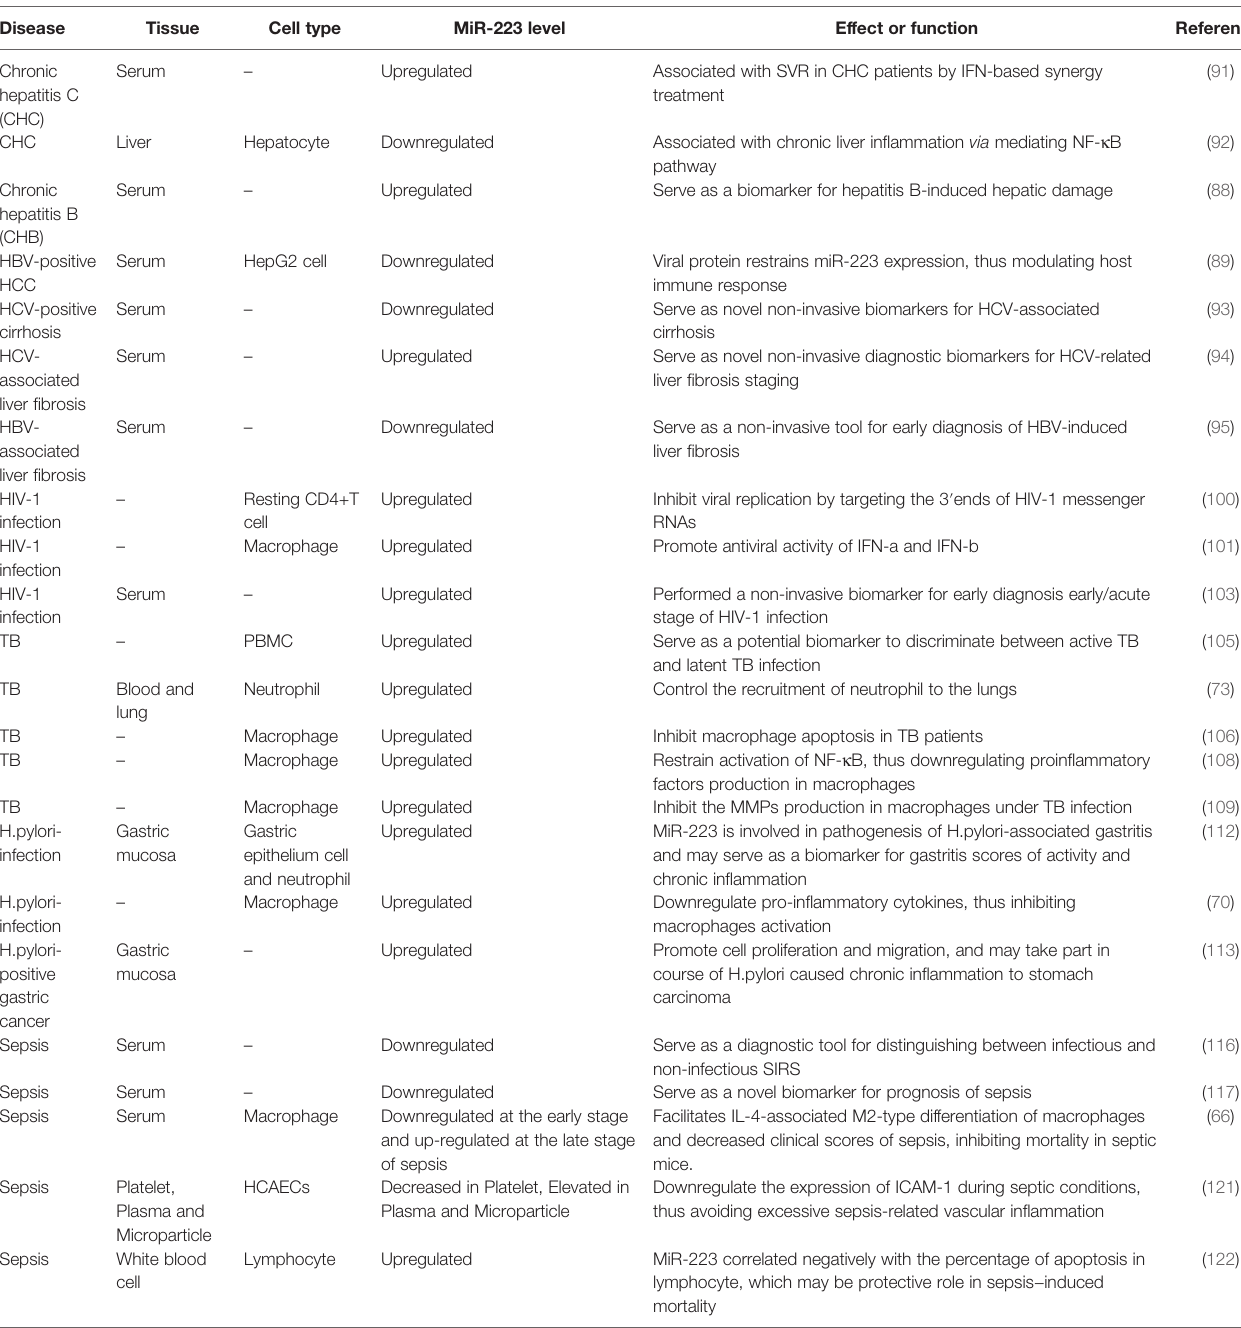
TABLE 2 | miR-223 expression in infectious diseases. Disease